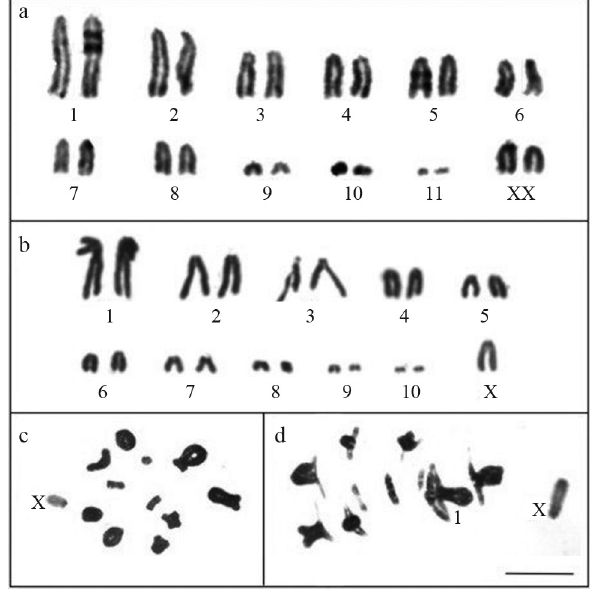
Figure1 - Conventionalstainingof O.rufipes (a,c)and E.fusiformis (b,d) cells. (a) and (b), karyotypes mounted based on female mitotic metaphase chromosomes and male anaphase I chromosomes, respectively; c, diakinesis; d, metaphase I. Note the submetacentric chromosome L 1 (b,d). Bar = 5 (cid:2)